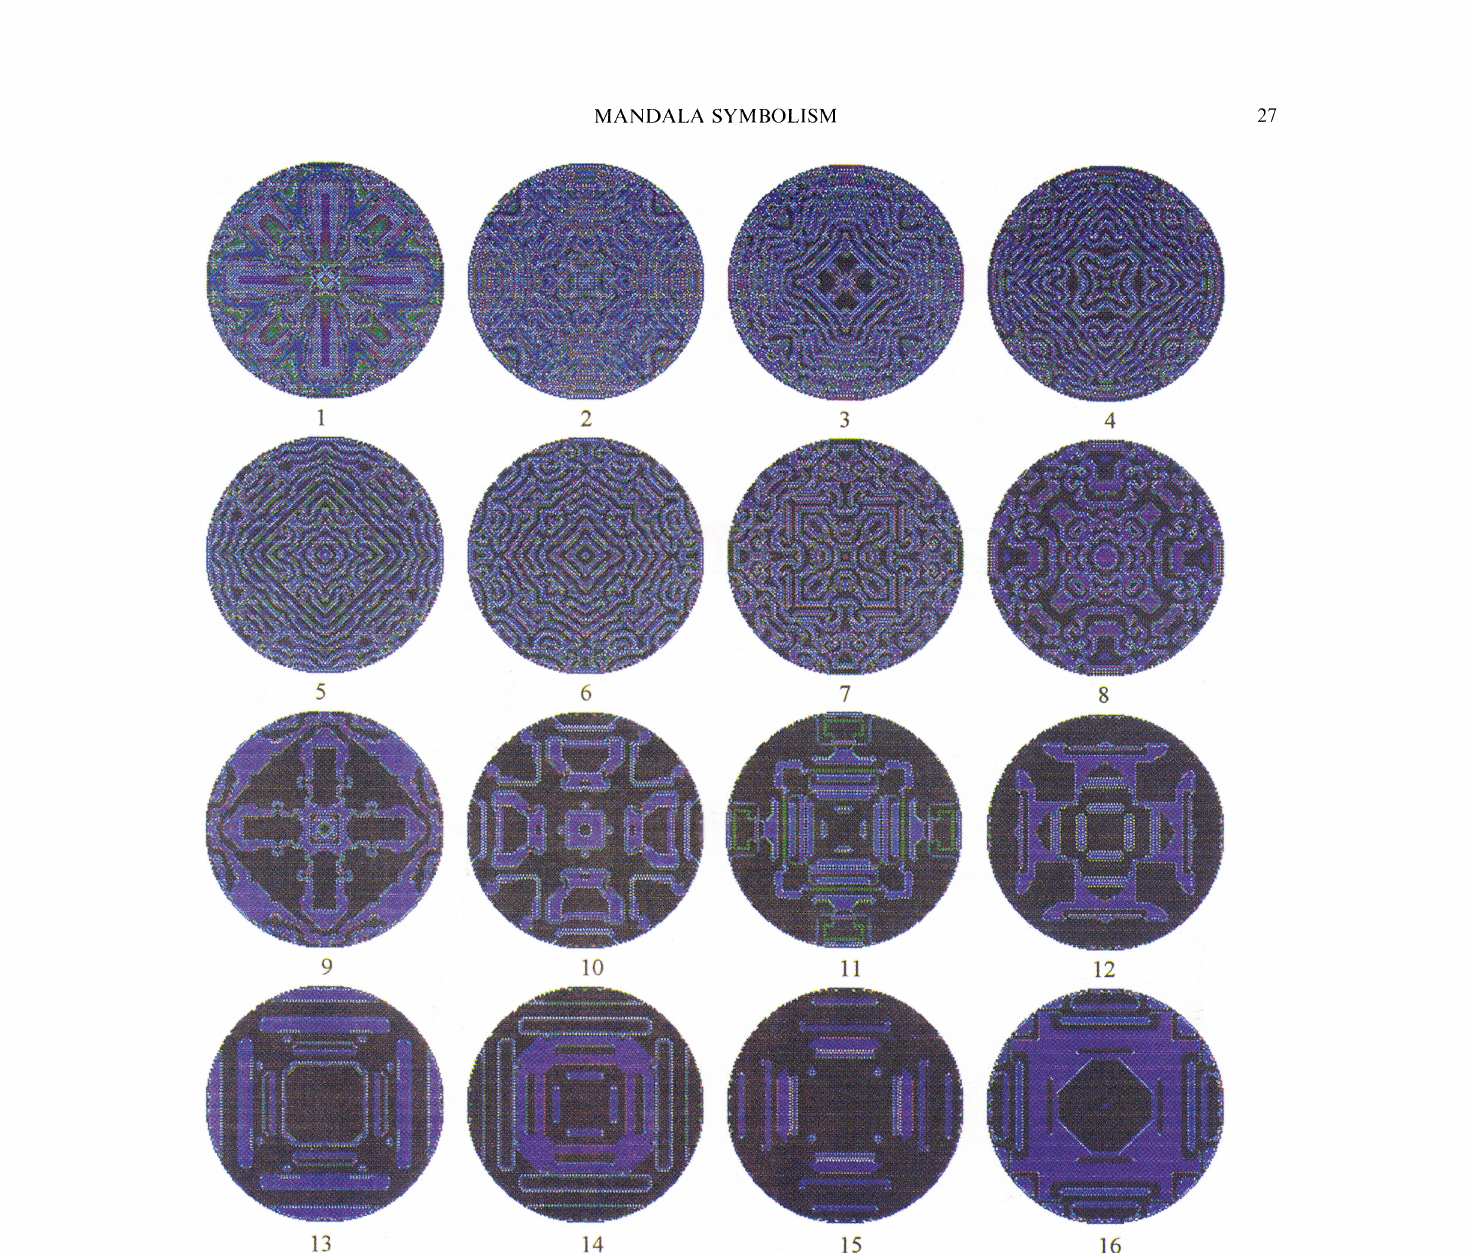
FIGURE 6 Mandalas calculated by the discrete chaotic dynamics algorithms. (See Color Plate